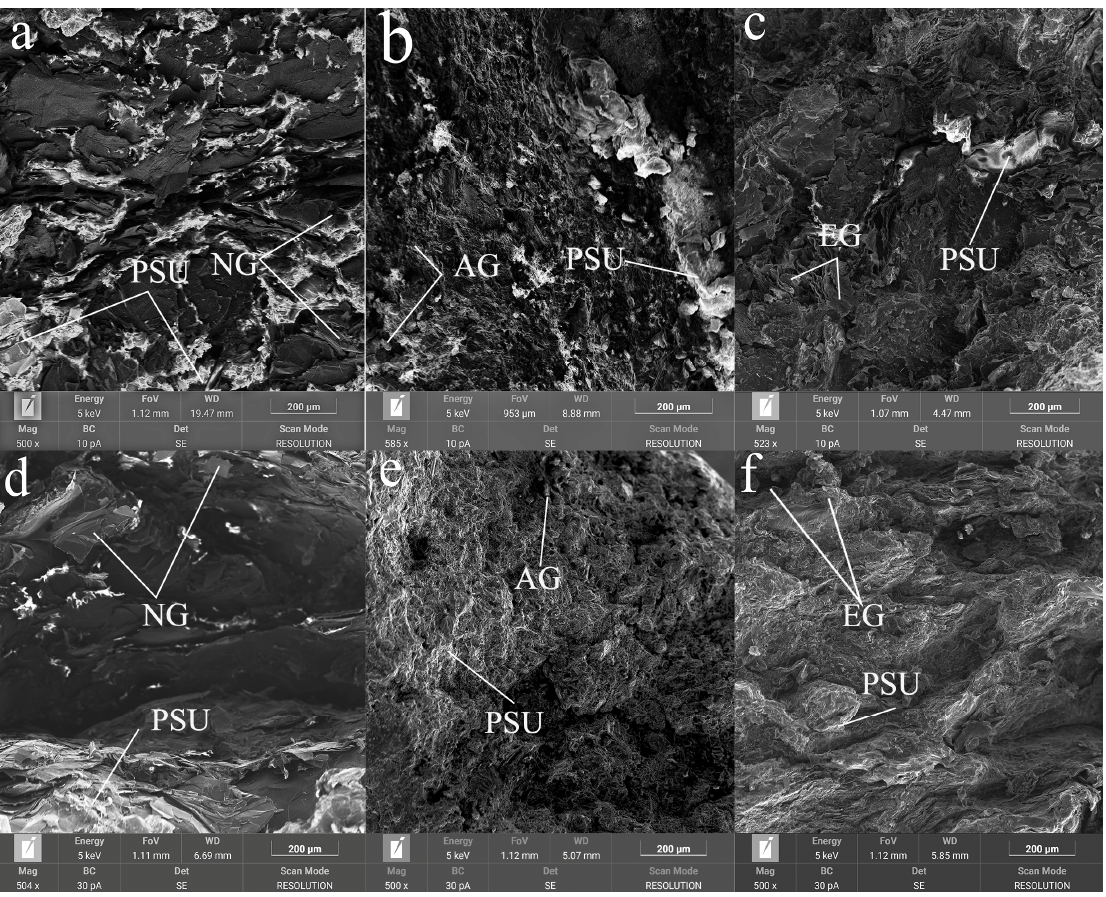
Figure 1. SEM micrographs of: polysulfone (PSU) + 30 wt.% NG ( a ); PSU + 30 wt.% AG ( b ); PSU + 30 wt.% EG ( c ); PSU + 70 wt.% NG ( d ); PSU + 70 wt.% AG ( e ); PSU + 70 wt.% EG ( f ) ×500.